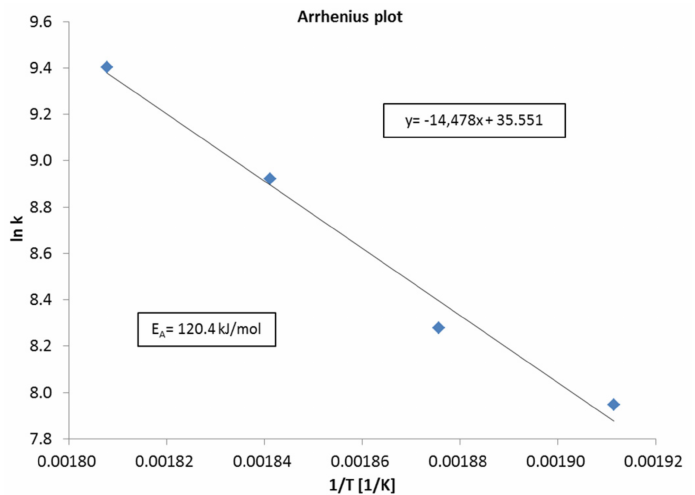
Figure 5. Arrhenius plot for the calculation of the apparent activation energy for CO 2 methanation on 18Ni/Al 2 O 3